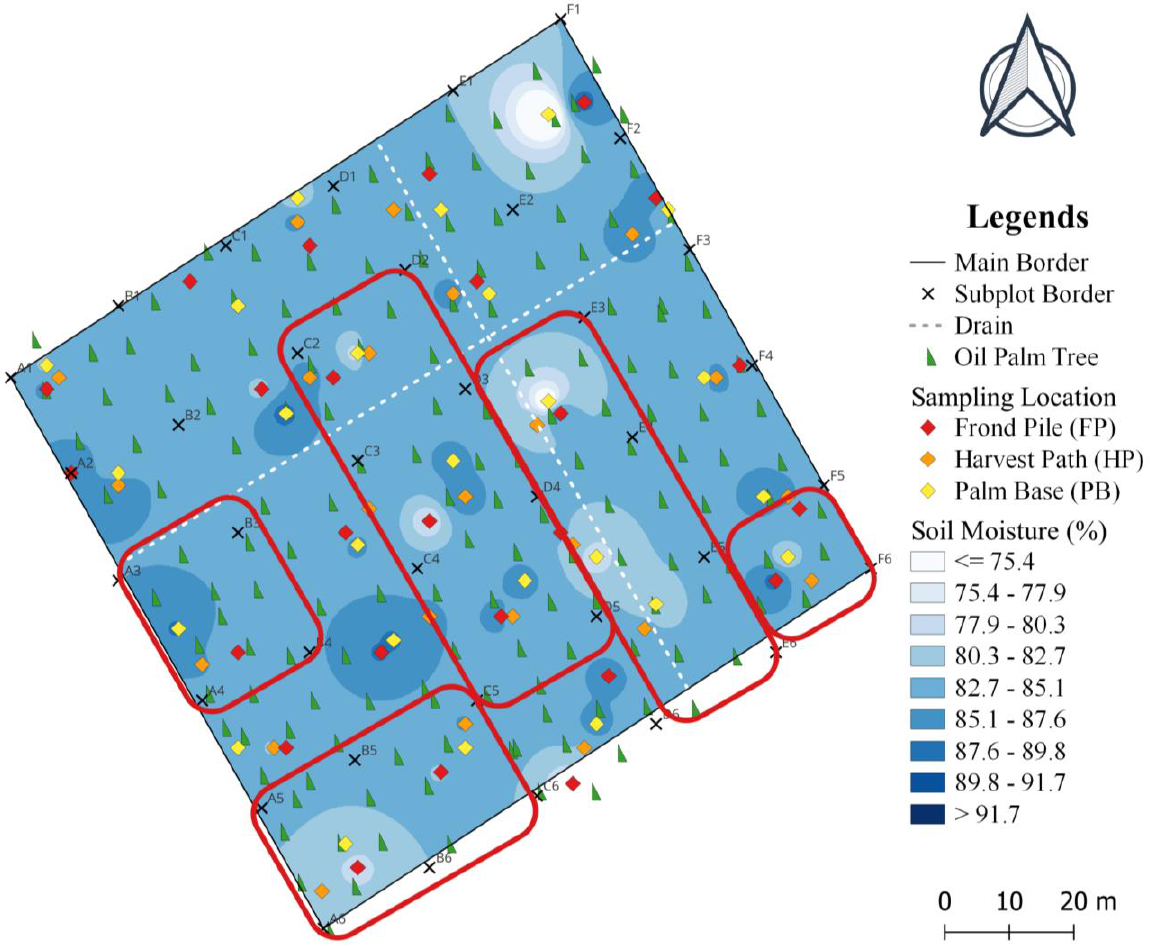
Figure 9. The spatial distribution of moisture content in the 0–50 cm soil layer at Sebungan Estate oil palm plantation (from Figure 4) with subplots where oil palm trees showed negative growth in trunk diameter identified (within the red